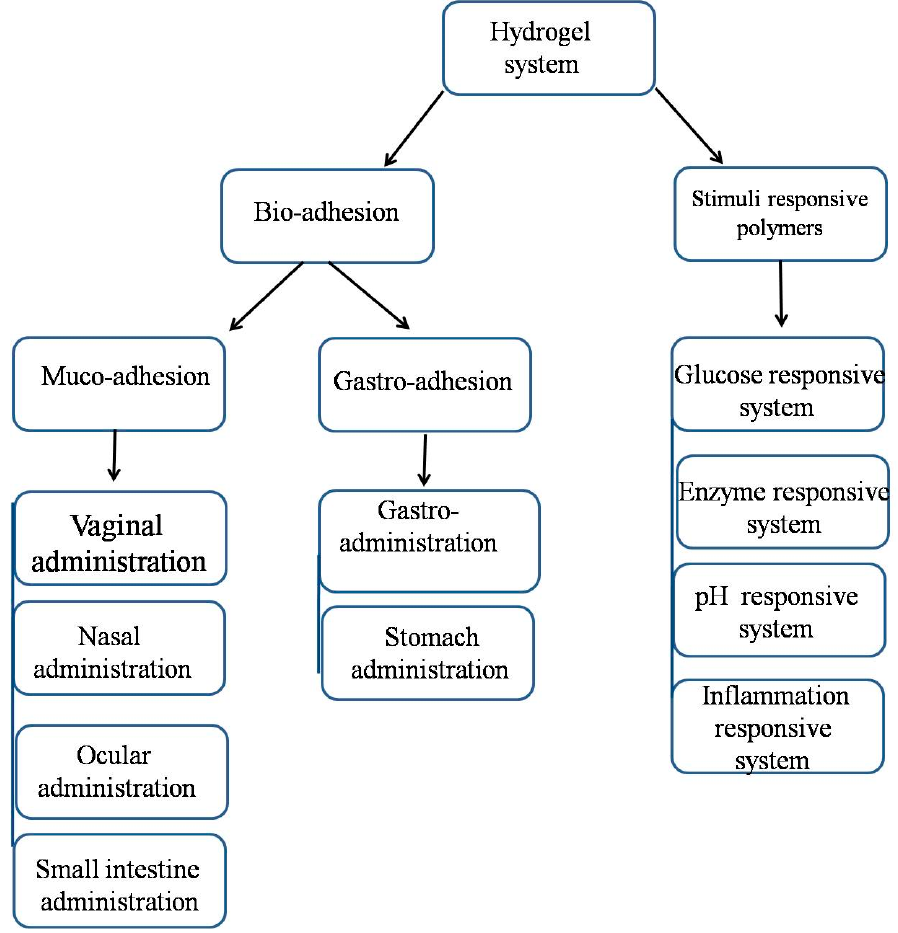
Figure 1. Classification of hydrogel systems according to their response to biological systems.